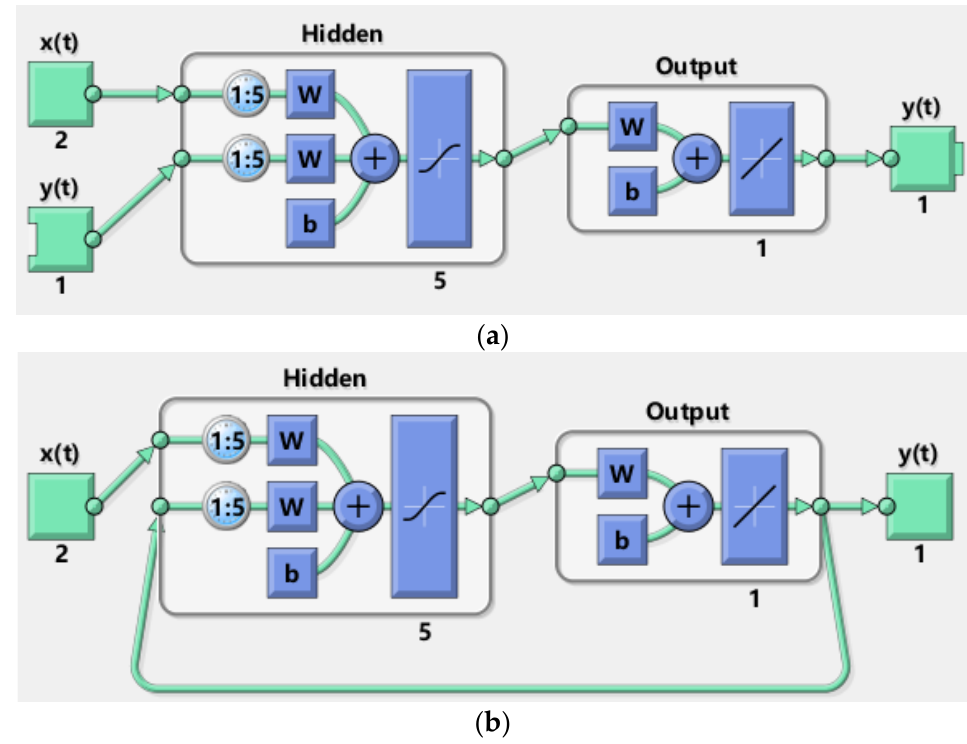
Figure 18. The diagram of the Matlab Neural Network tool-box for the NARX network. ( a ) Open-loop structure; ( b ) closed-loop structure.